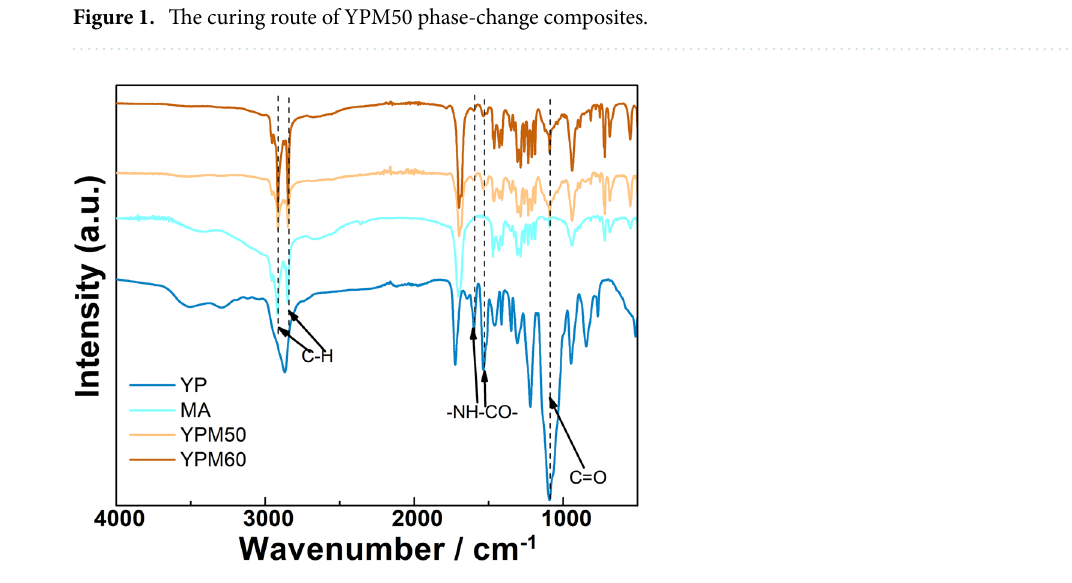
Figure 1. The curing route of YPM50 phase-change composites.